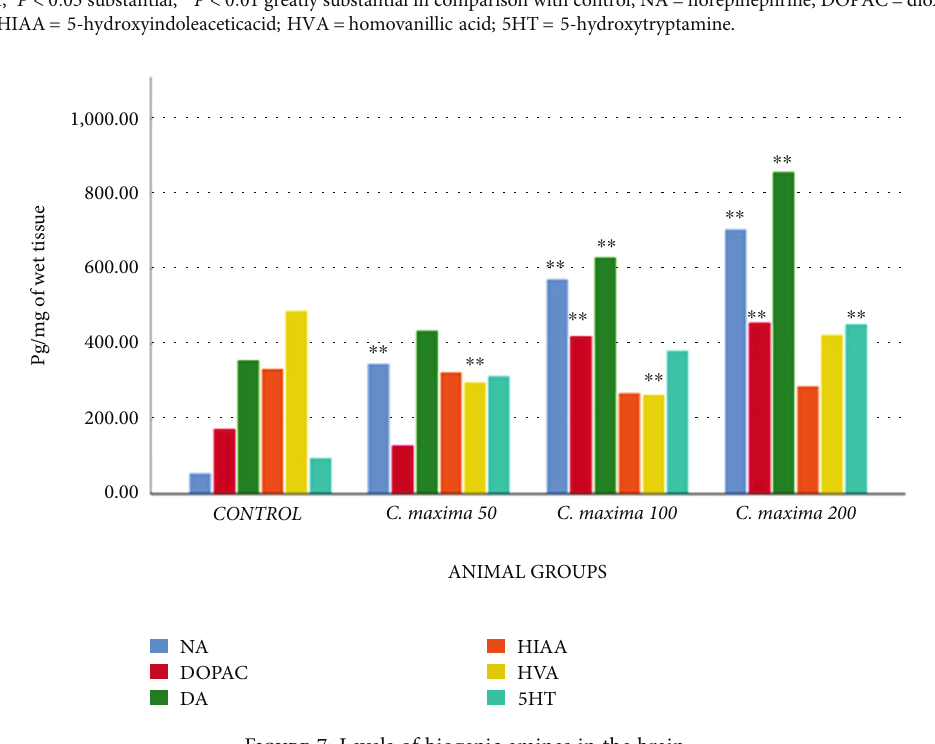
Figure 7: Levels of biogenic amines in the